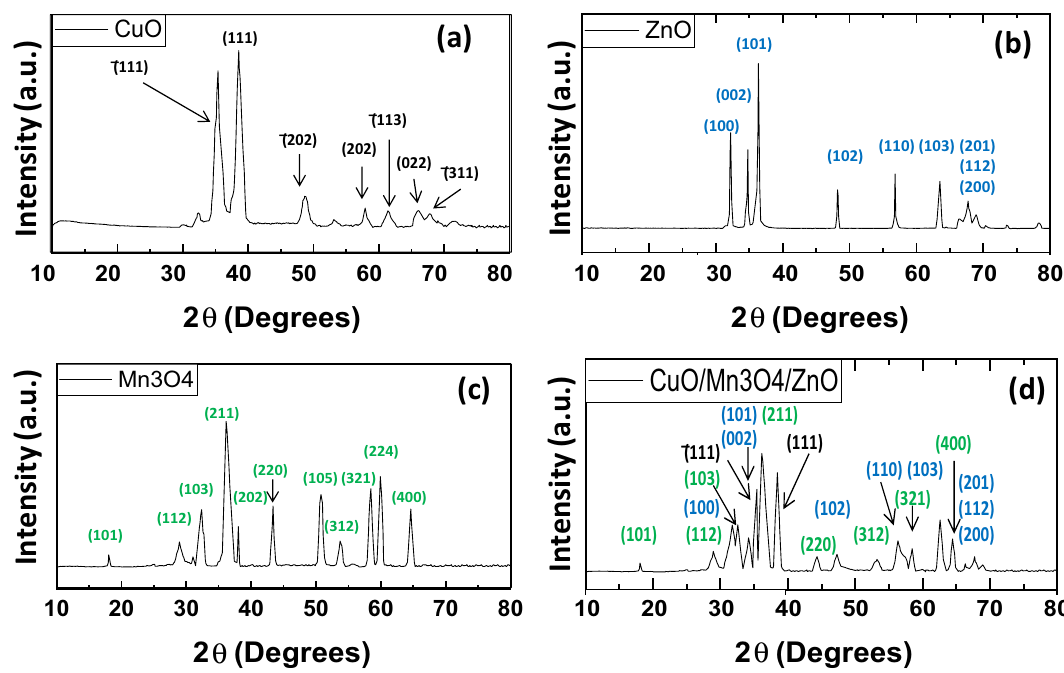
Figure 1. XRD patterns of pristine CuO, pristine ZnO, Pristine Mn 3 O 4 and ternary CuO/Mn 3 O 4 /ZnO